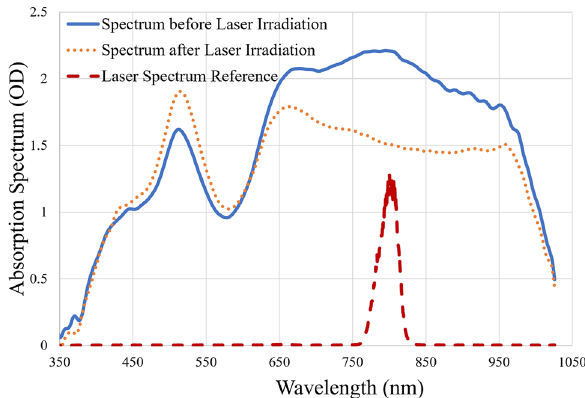
Figure 5. Absorption spectra of nanorod mixture before and after laser irradiation at fluence of 300 J/m 2